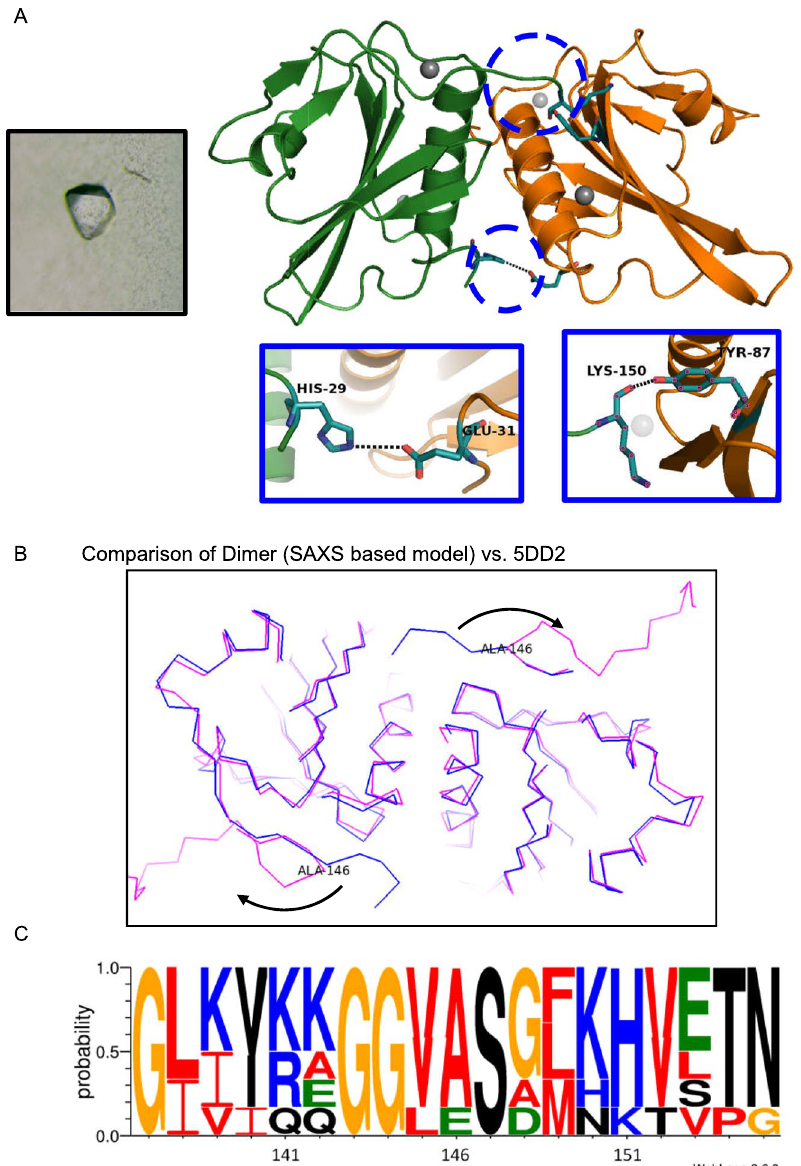
Figure 4. Crystal structure of the dimer of 28–161 in presence of Ca 2 + ions is presented here. ( A ) The image crystal used for diffraction is shown as left inset. The refined crystal structure is shown as ribbons (PDB ID5ZZ0). Specific interactions which contribute most to the interface are highlighted. ( B ) Comparison of the model built for dimer of 28–161 under Ca 2 + -free condition and compared with SAXS data (and based model) is shown here. The superimposed C α trace highlights that the Ala146 acts as a fulcrum of repositioning of the tail region upon binding to Ca 2 + ions. ( C ) The logo highlights the conservation of residues at different positions in sequence of the different gelsolin family